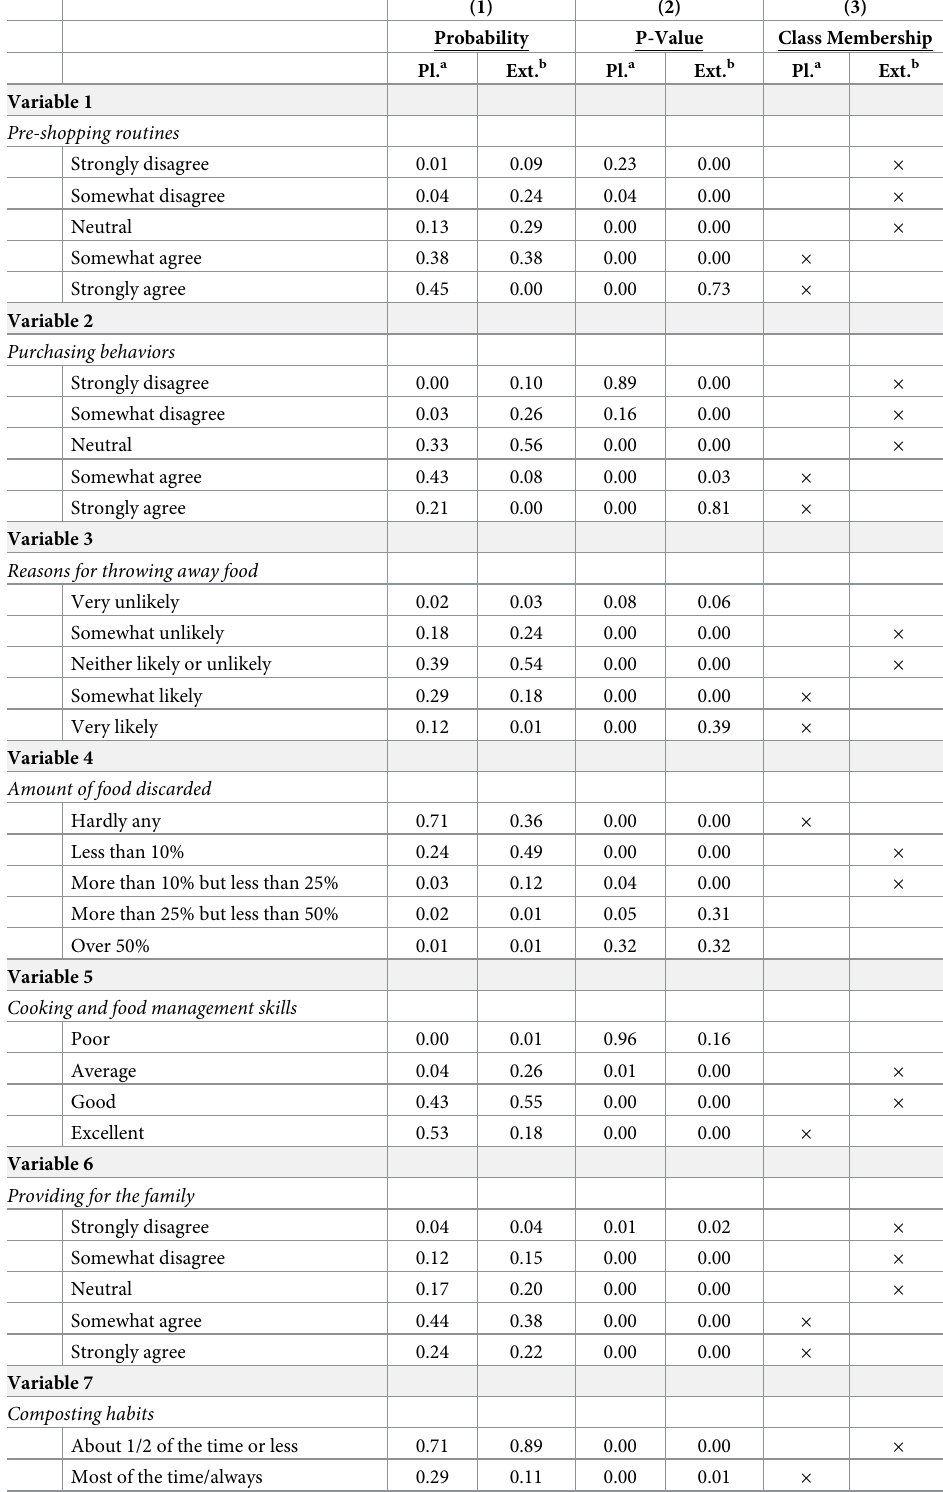
Table 5. Conditional response probabilities to response items and class